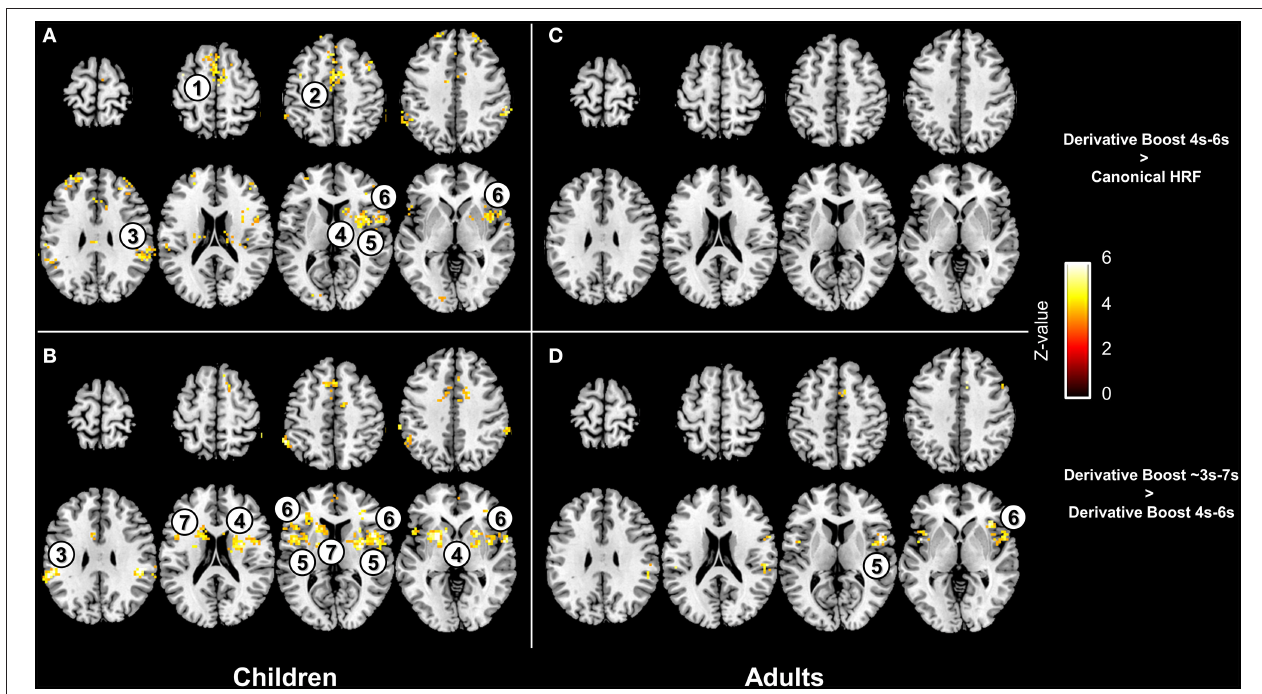
FIGURE 4 | Effect of the derivative boost on amplitude estimates in the 100Hz proprioceptive condition. Panel (A,C) display voxels where amplitude estimate is increased while using the derivative boost constrained between 4 and 6s (as compared with the model including the canonical HRF alone) in children and adults. Panel (B , D) illustrate additional increase in amplitude estimates while using the full derivative boost compared to that constrained between 4 and 6s, in children and adults. Maps are thresholded at a voxel-wise threshold of p < 0.001 uncorrected and a cluster extend threshold of p < 0.05 FWE-corrected. Numbers refer to main regions in which amplitude estimate was increased; 1, supplementary motor area; 2, anterior cingulate cortex; 3, inferior parietal lobule; 4, putamen; 5, anterior insula; 6, inferior frontal gyrus; 7,